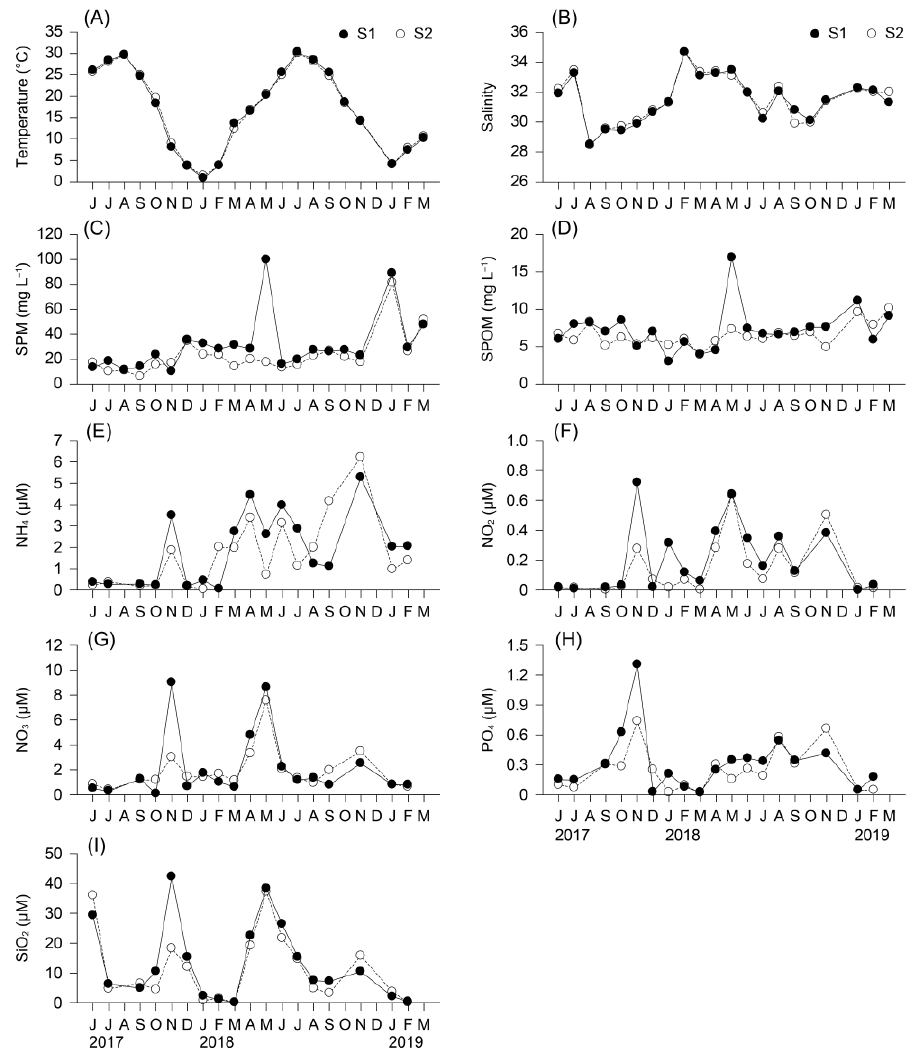
Figure 2. Seasonal variations in the environmental factors and nutrient concentrations, including ( A ) water temperature, ( B ) salinity, ( C ) suspended particulate matter (SPM), ( D ) suspended particulate organic matter (SPOM), ( E ) ammonium (NH 4 ), ( F ) nitrate (NO 2 ), ( G ) nitrate (NO 3 ), ( H ) phosphate (PO 4 ), and ( I ) silicate (SiO 2 ), in subsurface water at the sampling sites. Diatoms predominated at both stations, with an average contribution of 74.0% at S1 and 73.6% at S2. In spring (May–June), the contribution of diatoms dropped to 36.4% at S1, followed by cryptophytes (28.3%) and prasinophytes (18.0%). During that period,